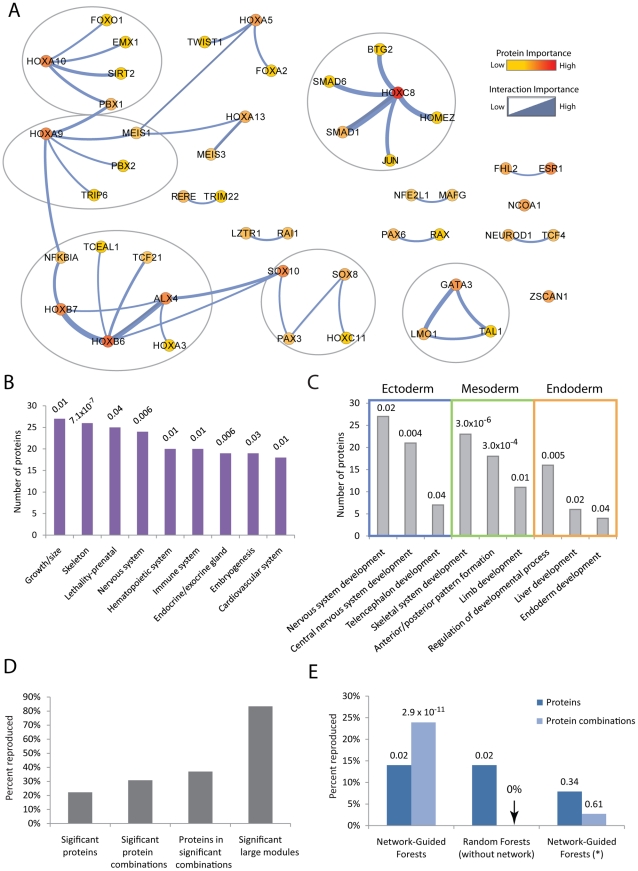
Network modules capture causal developmental factors and are reproducible.(A) Consensus network modules underlying tissue origin (modules of size greater than 2 are encircled). Gene pairs that often co-occur in the same decision trees and are most important for classification are shown in blue. Node color indicates protein importance whereas edge width indicates the importance of a protein combination. (B) Enrichment for developmentally-related phenotype categories in the MGI database (FDR is reported above each bar). (C) Enrichment of germ-layer specific genes identified by NGF based on the Gene Ontology (FDR is reported above each bar). (D) Percentage of genes, interactions, and modules that were reproduced based on an independent dataset. (E) Percent of reproduced single genes and gene combinations (Fisher's Exact Test P-values are reported). NGF* indicates the result for NGF applied to networks with perturbed expression measurements.